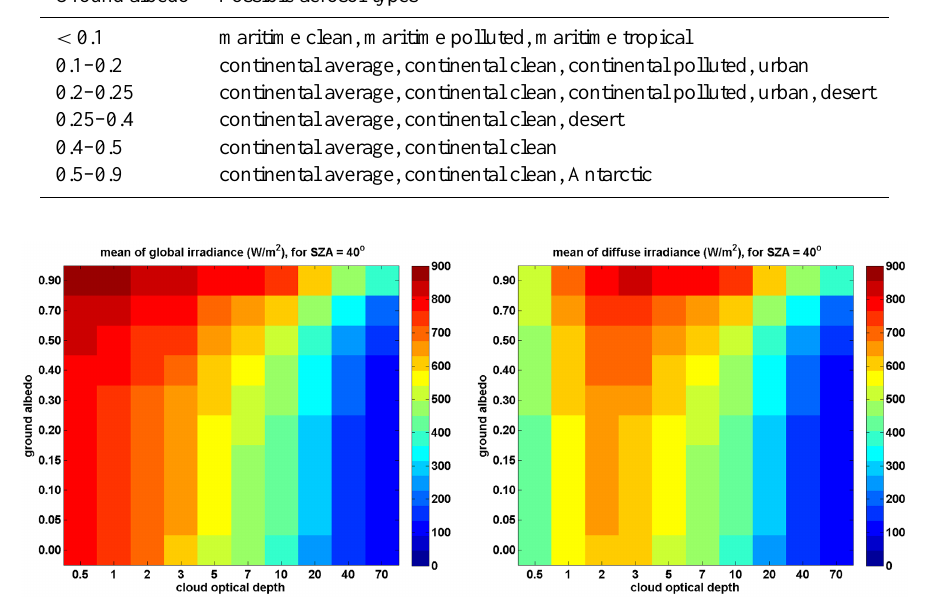
Figure 1. Average of G (left) and D (right) for θ S = 40 ◦ as a function of ρ g and τ c for water